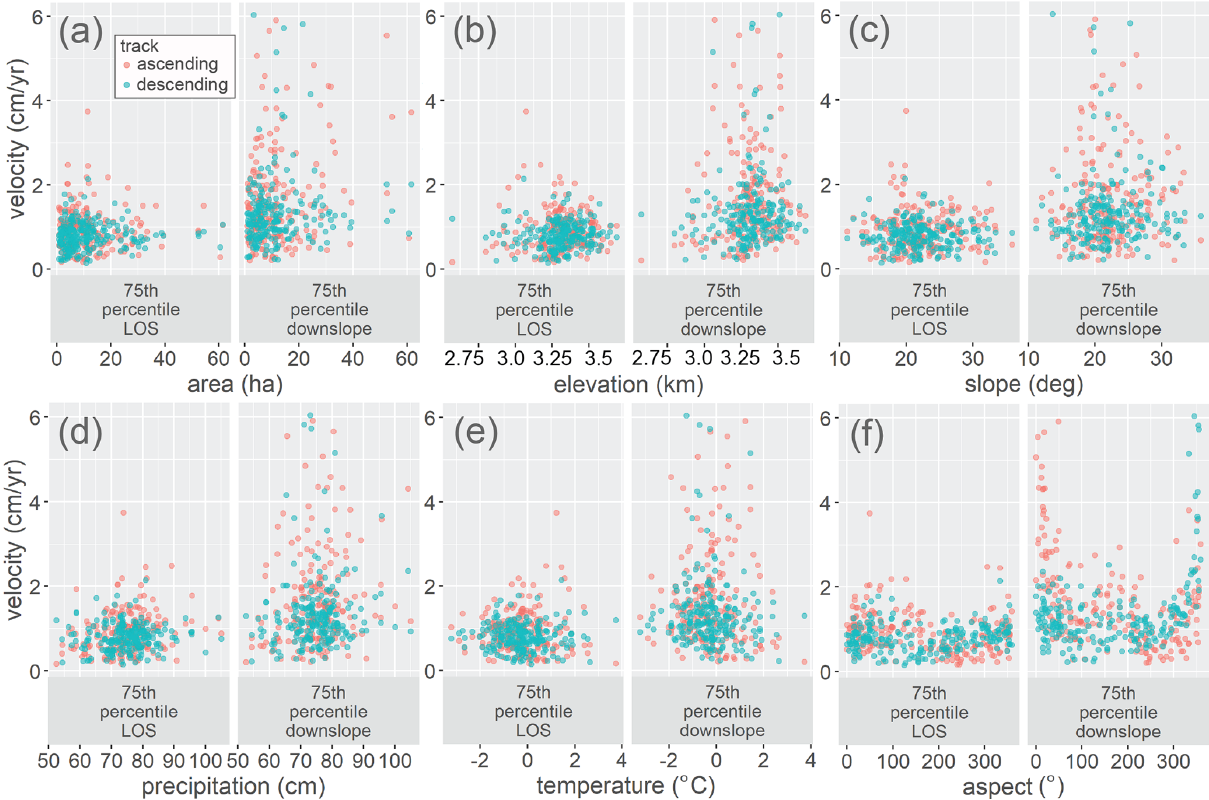
Figure A2. Rock glacier velocity plotted against physical variables and climate envelope. In all plots, velocity is the absolute value of 75th percentile LOS velocity on the left and 75th percentile downslope velocity on the right, compared to (a) rock glacier area, (b) rock glacier elevation, (c) rock glacier slope, (d) rock glacier mean annual precipitation, (e) rock glacier mean annual air temperature, and (f) rock glacier aspect. Two velocity values are presented for each rock glacier: one is derived from the ascending 1-year stack (red) and one from the descending 1-year stack (blue). Temperature and precipitation data are from PRISM, and n =